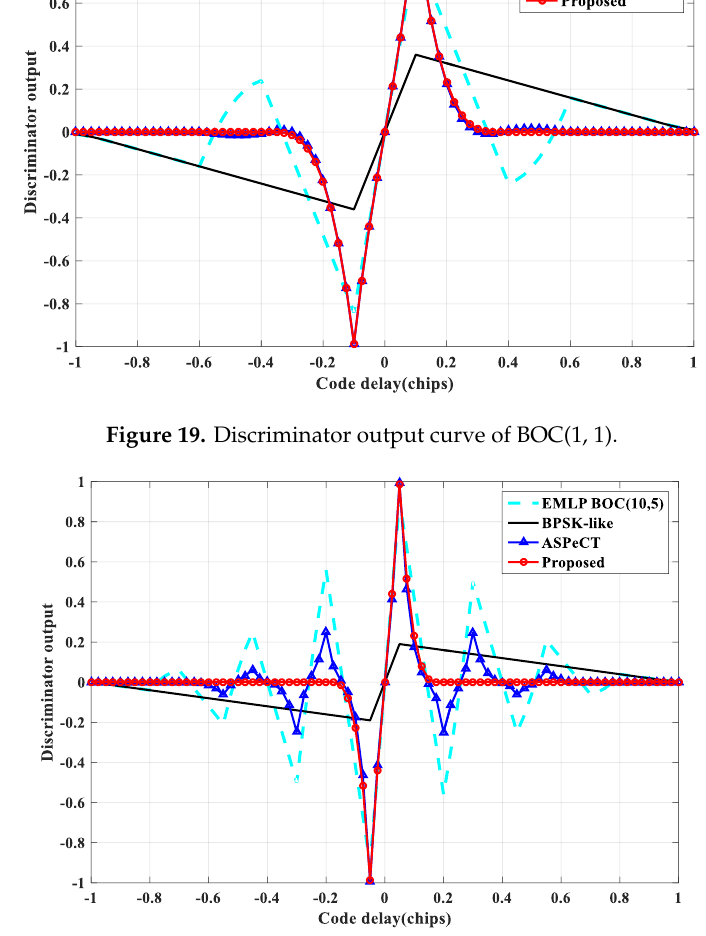
Figure 20. Discriminator output curve of BOC(10,5).